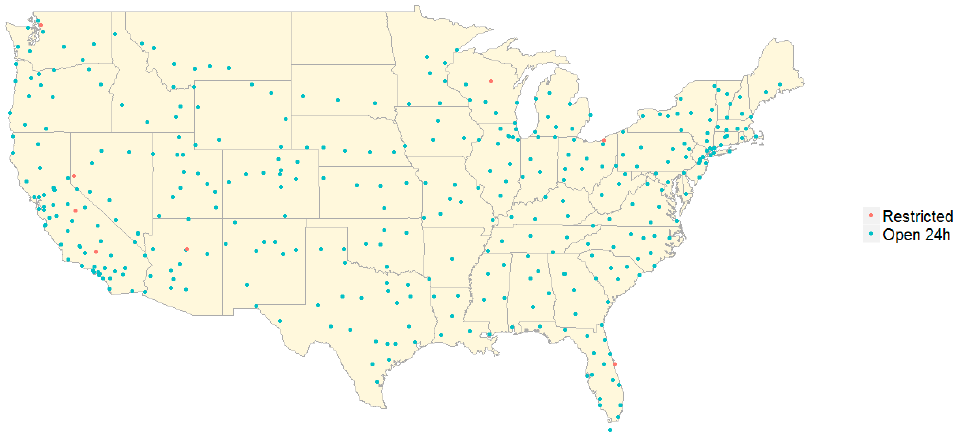
Figure 1. Tesla Superchargers network in the U.S.